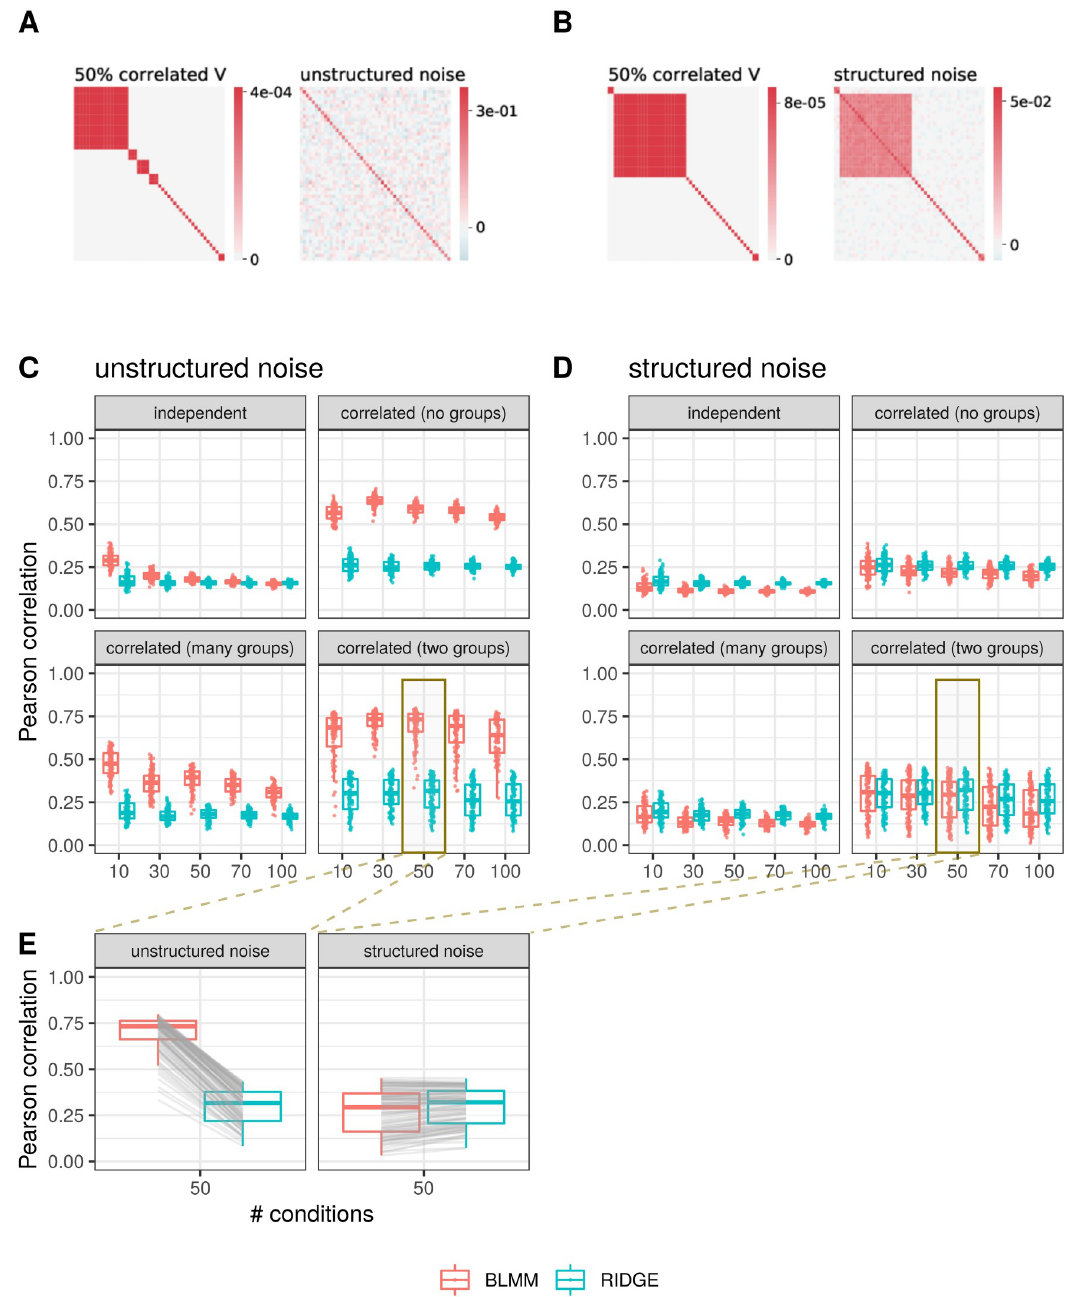
Fig 2. Simulation study. Data is generated over G = 978 informative genes and T = 623 motif scores and 100 repetitions, with either unstructured noise S C (A,C) or structured noise S C (B,D). (A,B): exemplary covariance matrix between samples, V C , and noise matrix S C being unstructured (A) or structured (B). Data is shown for C = 50 samples with a covariance between conditions with k = 25 blocks, i.e. 25 sample groups, in which samples are completely correlated. (C) and (D): The Pearson correlation values between generated and estimated motif-condition-weights are shown for different degrees of correlation between samples. The values are depicted per method used to predict the motif-condition-weights: the Bayesian Linear Mixed Model (BLMM, in red), which allows for dependence between samples, and the Ridge Regression (RIDGE, in blue), which assumes independence between samples. Data is generated with the following covariances between samples. (i) independence between samples, V = I , (ii) C C unrestricted correlation between samples, (iii) correlated data with many sample groups, and (iv) highly correlated samples, assuming samples originate from two biologically different samples. Results are shown based on data generated with unstructured noise ((C), see (A)), or with structured noise ((D), see (B)). (E): Exemplary comparison of Pearson correlation values between simulated and predicted posterior motif influence ^ o . The data is generated with highly correlated samples, modeling two groups T ; C of biological replicates. Corresponding replicates are combined by a gray line. The data in the left panel is generated with unstructured noise S C (see (A)) and in the right panel with structured noise (see (B)).